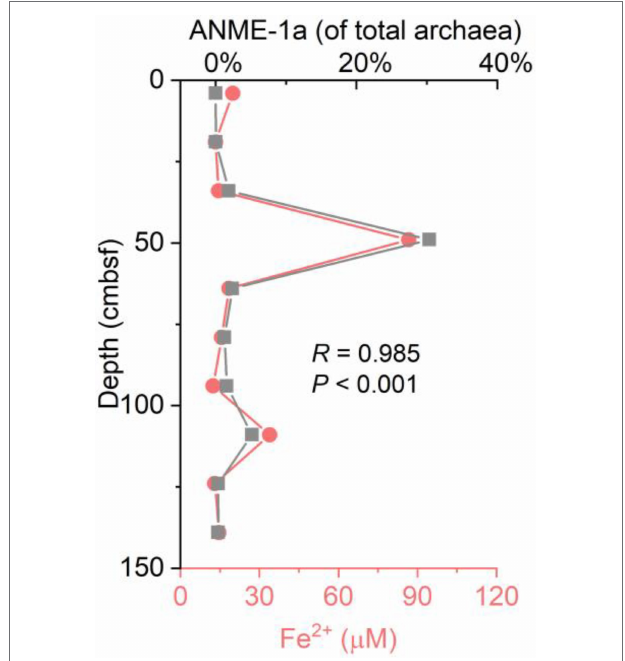
FIGURE 8 | Profiles showing the relative abundance of ANME-1a and corresponding concentrations of pore water dissolved iron from gravity core